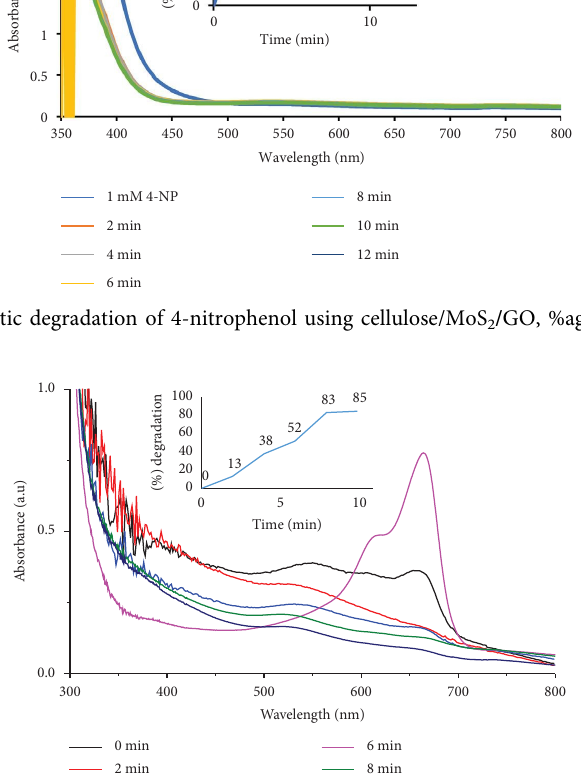
2 / GO, %age degradation